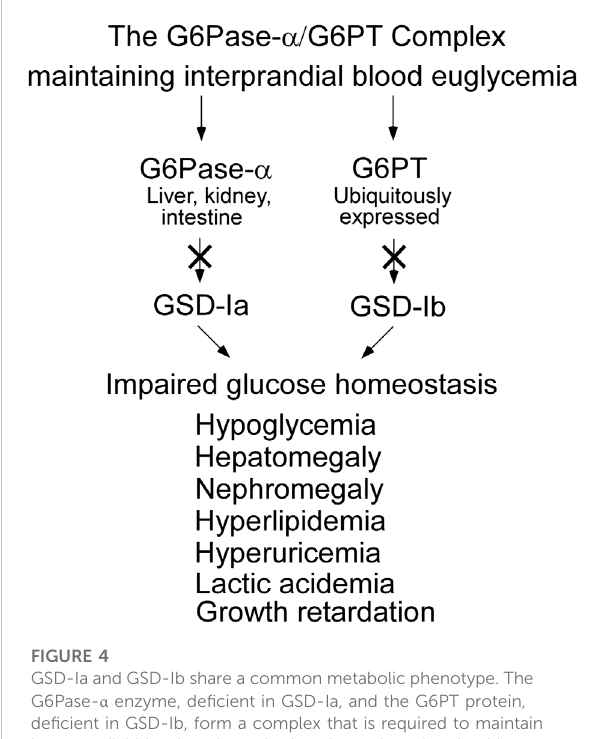
FIGURE 4 GSD-Ia and GSD-Ib share a common metabolic phenotype. The G6Pase- α enzyme, de fi cient in GSD-Ia, and the G6PT protein, de fi cient in GSD-Ib, form a complex that is required to maintain interprandial blood euglycemia. A pathogenic variant in either disrupts the function of the complex leading to a common metabolic phenotype, whose initial presentation is impaired blood glucose